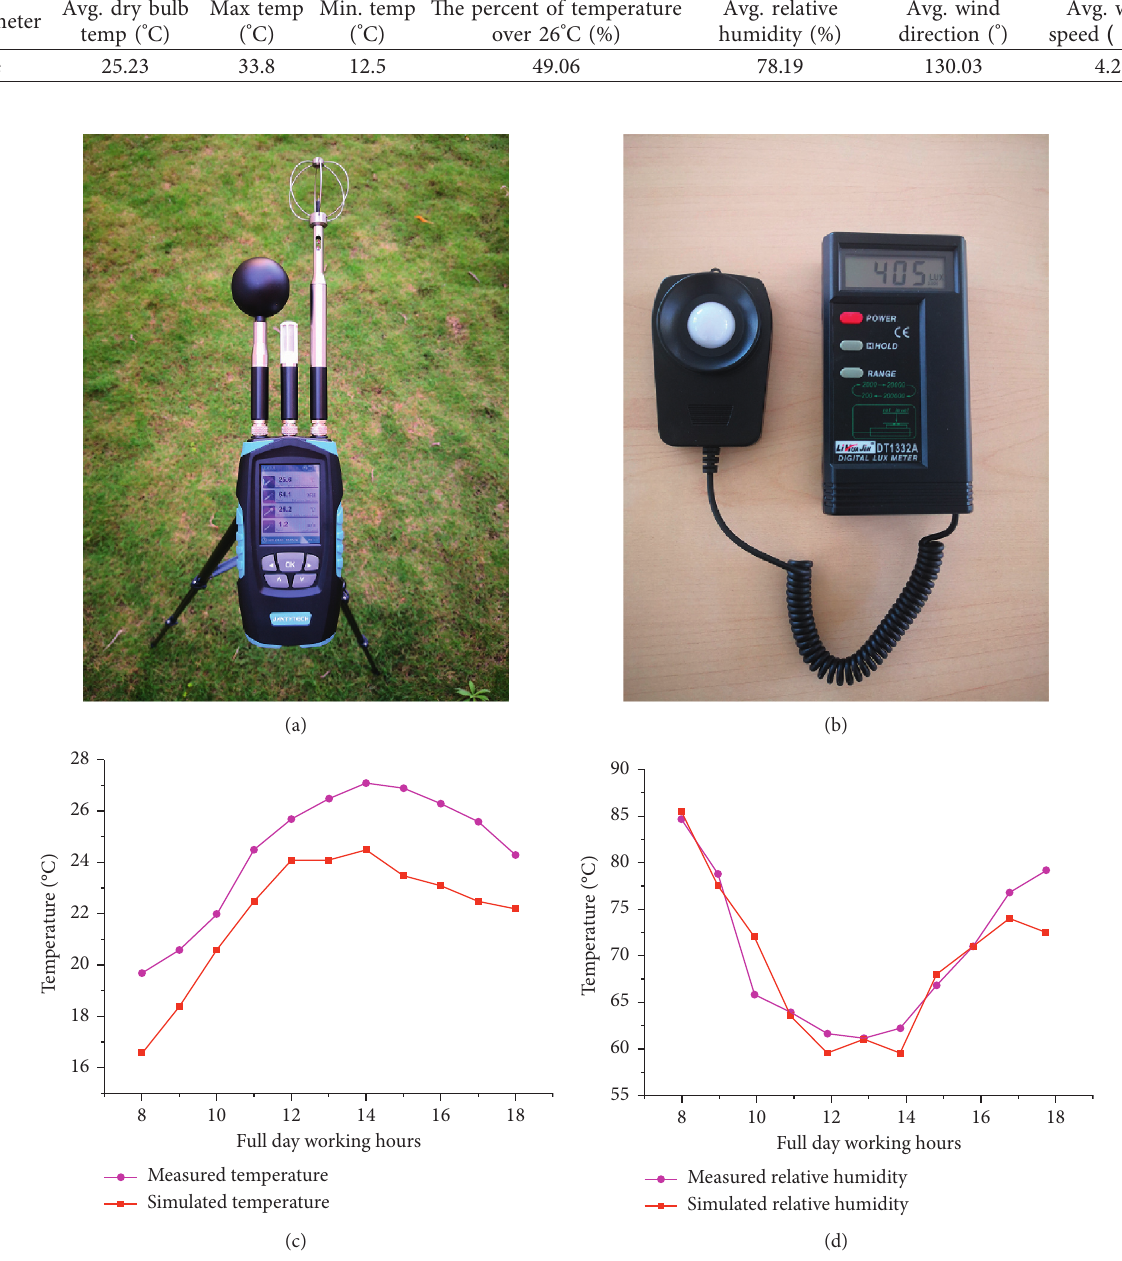
Figure 3: Actual measured and simulated temperature, humidity, and measured illumination. (a) Temperature and humidity tester is JT2020 Multifunction Tester; (b) tester is DT-1332A Digital Illuminance Meter. (c) and (d) Comparison between real temperature and humidity and simulated temperature and humidity on January 7 and 9,